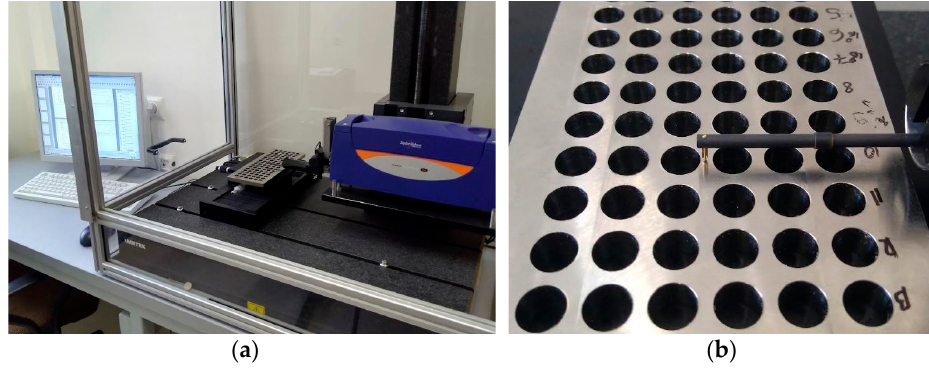
Figure 3. Burr height measurement stand ( a ), measured workpiece ( b ).